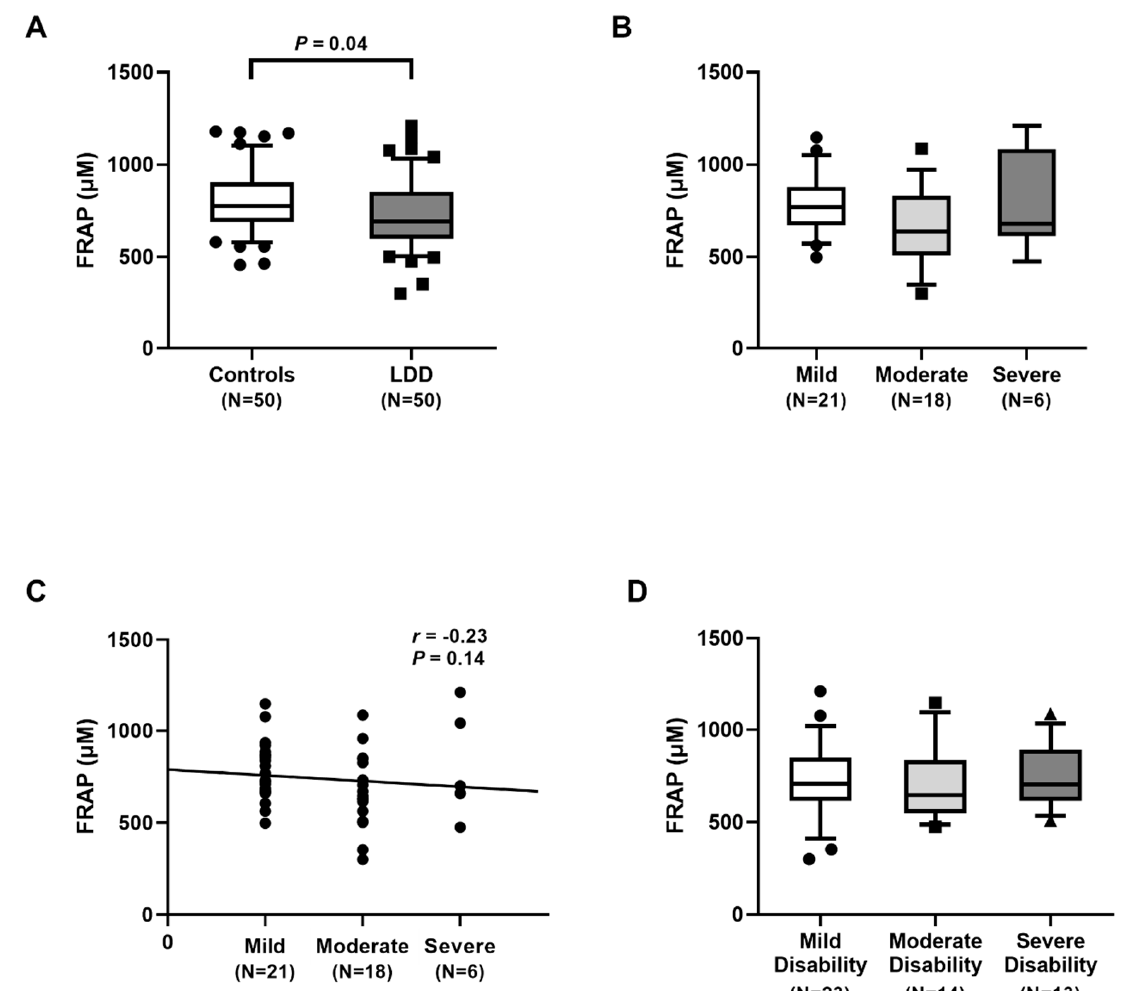
Figure 5. Determination of ferric reducing antioxidant power ( FRAP ) values: ( A ) comparison of FRAP values in lumbar disc degeneration (LDD) patients and controls. Circles represent control group, squares LDD group; ( B ) comparison of FRAP values in LDD, based on the radiographic severity. Circles represent mild group, squares moderate group; ( C ) correlation of FRAP values and the radiographic severity. Circles represent individual data points; ( D ) comparison of FRAP values in LDD, stratified by Oswestry disability index score . Circles represent mild group, squares moderate group, triangles severe group.